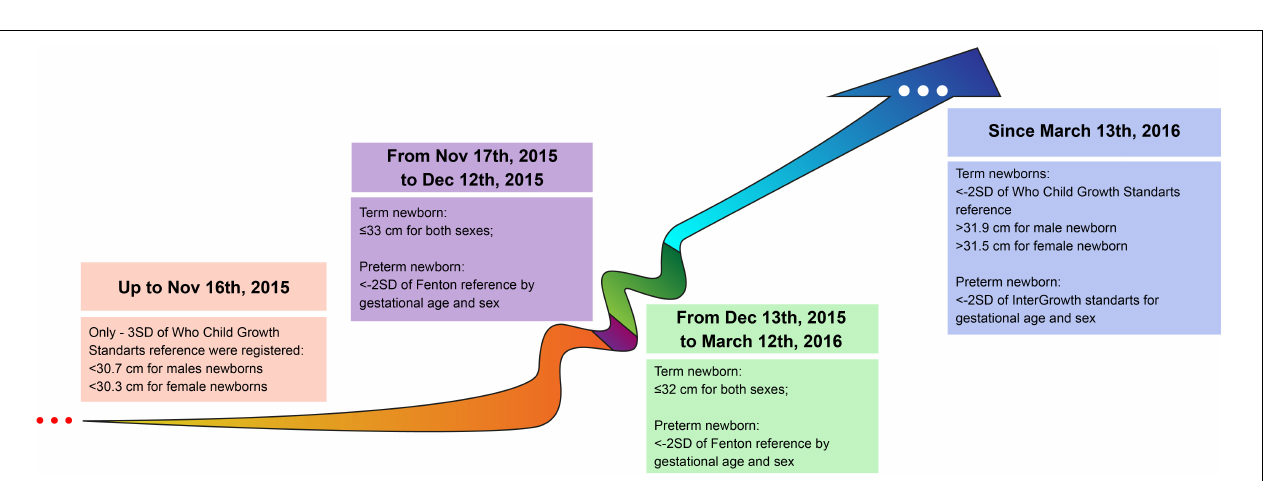
Frontiers in Neuroscience |